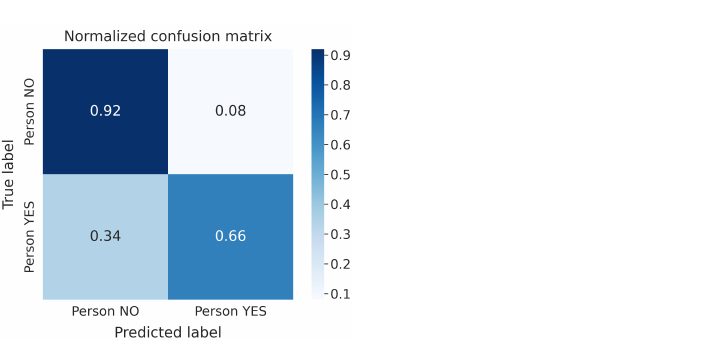
Figure 9. 2D data projection with K-Means t-SNE model—all attributes, static case.